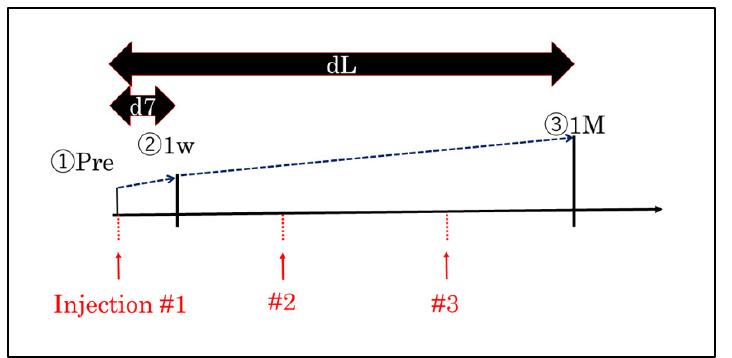
Figure 1. Flow chart of this